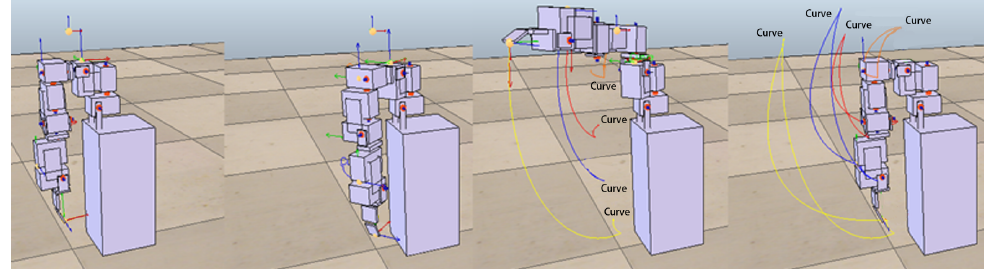
Figure 8. The motion trajectory of the swinging → side-lifting action. The robotic arm first performs the swinging motion, then performs side-lifting motion, and finally returns to the original starting state.